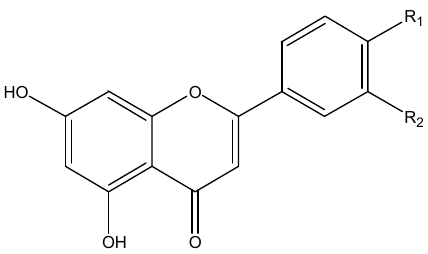
Figure 5. The chemical structures of apigenin (R 1 = OH, R 2 = H), chrysin (R 1 = R 2 = H) and luteolin (R 1 = R 2 = OH).